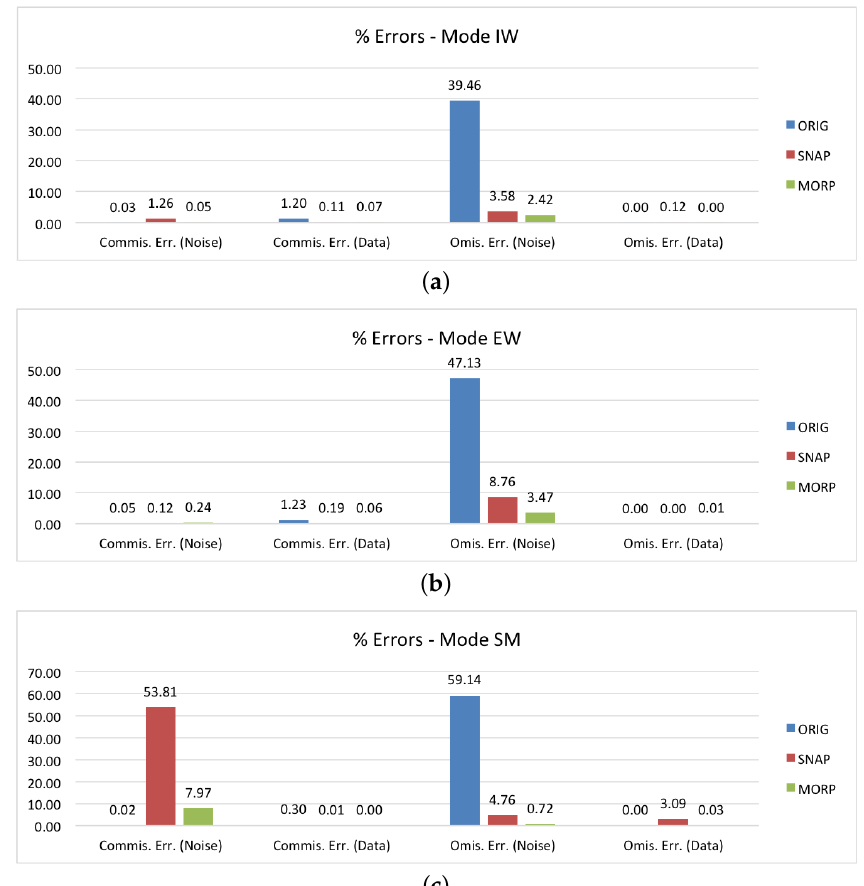
Figure 7. Performance assessment of the proposed method ( MORP ), compared to the original unmasked images ( ORIG ) and the images masked via SNAP’s ‘Remove GRD Border Noise’ module ( SNAP ): ( a – c ) commission/omission errors disaggregated by the acquisition mode.